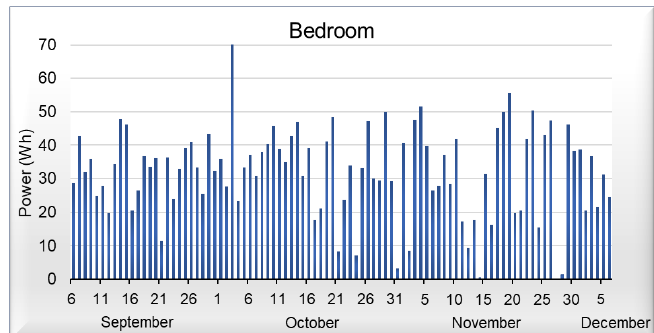
Figure 9. Power consumed by the bedroom